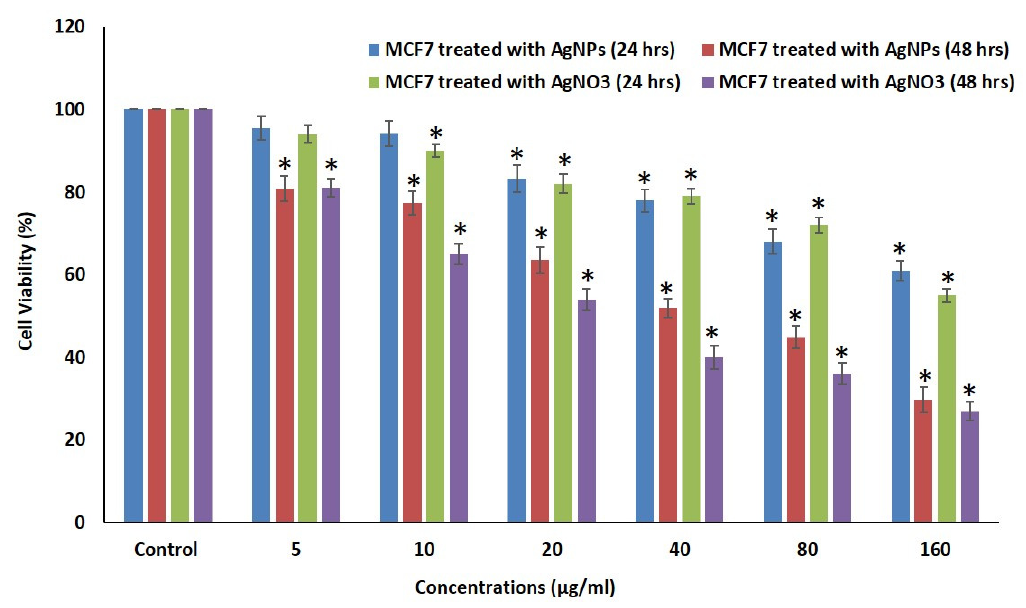
Figure 7. Inhibitory outcome of AgNO 3 and AgNPs manufactured from leaves extract of Asf on MCF7 cells at 24 and 48 hrs. Values are given as mean ± S.D. for each concentration. *Indicates the treated concentrations statistically significant ( p < 0.05) when compared to control.